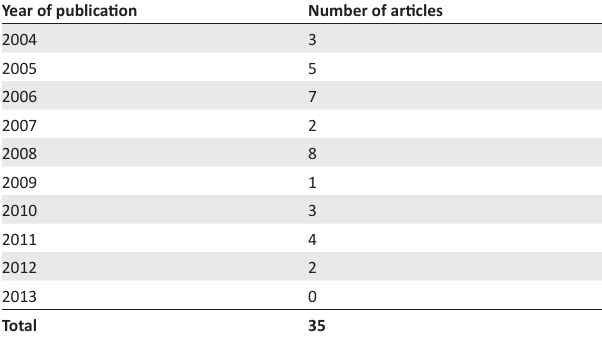
TABLE 4: Number of publications per year